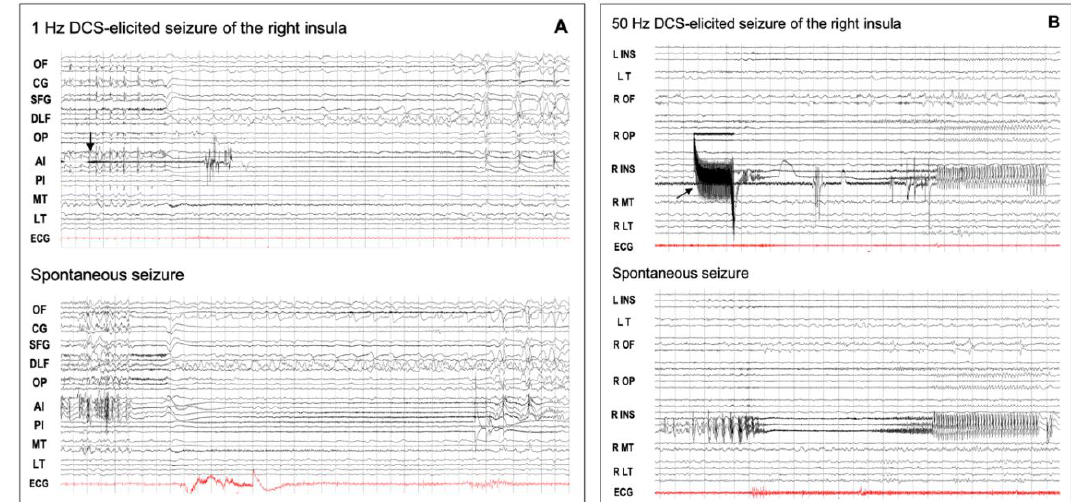
Figure 4. DCS-induced seizures. ( A ) Low-frequency (1 Hz) DCS-induced and spontaneous insular seizures. This 18-year-old male patient had seizures characterized by an explosive hypermotor behavior without any aura. From the start of stimulation (arrow), the elicited discharge was quite visible between the DCS artifacts, and its spatio-temporal organization was quite similar to that of the spontaneous seizure. OF: orbito-frontal cortex; CG: cingulate gyrus; SFG: superior frontal gyrus; DLF: dorsolateral frontal cortex; OP: opercular cortex; AI: anterior insula; PI: posterior insula; MT: mesio-temporal structures; LT: lateral temporal cortex; ECG: electrocardiogram. ( B ) High-frequency (50 Hz) DCS-induced and spontaneous insular seizures for the same patient as in Figure 2. The right postero-superior insular DCS (arrow) induced a seizure which showed the same time evolution and spatial organization as that of the spontaneous discharge, except that the initial part of the elicited discharge was masked by DCS artifacts. DCS: direct cortical stimulation; L: left; R: right: INS: insula; T: temporal lobe; OF: orbito-frontal cortex; OP: opercular region; MT: mesio-temporal structures; LT: lateral temporal cortex; ECG: electrocardiogram. These EEG recordings can be viewed in a larger size in the supplemental material (Figure